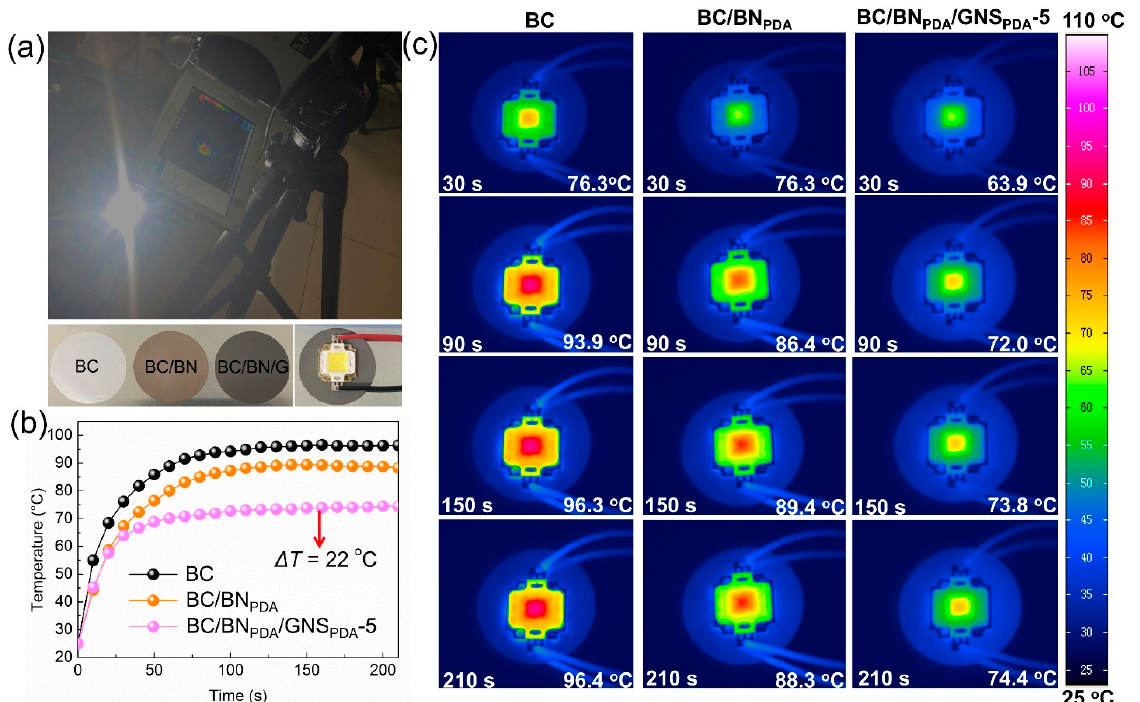
Figure 5. ( a ) Experimental con fi guration for testing the heat transfer performance of BC, BC/BN PDA , and BC/BN PDA /GNS PDA -5 fi lms applied to LED chip heat dissipation. ( b ) Temperature evolution of LED chip as a function of running time and ( c ) the corresponding IR images of temperature distri- butions of BC, BC/BN PDA , and BC/BN PDA /GNS PDA -5 fi lms. The reduction of electron delocalization arising from the ionic characteristic of the B − N bond generally brings about large band gap of the BN fi ller, which provides the ex- cellent electrical insulating features of composites [41]. Conversely, the conjugated struc- tures of GNS has high electron mobility (2 × 10 5 cm 2 ·V − 1 ·s − 1 ) [24], which leads to poor elec- trical insulation properties. It was found, surprisingly, that the electrical insulation prop- erties can be regulated by controlling the mass ratio of GNS PDA . Figure 4d,e depicts the dielectric constant ( ε ) and dielectric loss (tan δ ) of composite fi lms at varied fi ller content. It can be seen that the ε and tan δ values of BC/BN PDA /GNS PDA -5 fi lms are clearly reduced with the increase in hybrid fi llers contents, which has a similar trend seen in the literature [5,37]. For example, the ε and tan δ values of the BC/BN PDA /GNS PDA -5 composite fi lm with 70 wt% hybrid fi llers contents separately reach the extremely low values of 6.3 and 0.03 at the frequency of 1000 Hz, which are lower than that of the fi lm with 10 wt% hybrid fi llers (8.1 and 0.05). This is because the BN is the main fi ller, which exhibits an extremely low values of ε and tan δ (~ 4, ~5 × 10 − 4 ) [42]; that being said, some studies have reported that the addition of GNS causes the enhancement of ε due to the interfacial polarization e ff ect and the formation of the micro-capacitance [43]. However, for the hybrid fi ller of the pre- pared BC/BN PDA /GNS PDA -5 fi lm, the content of GNS fi ller (5 wt%) is much lower than that of the BN fi ller (95 wt%), and the small amount of GNS is isolated by numerous BN fi llers, so the GNS fi ller fails to form micro-capacitances inner composites. However, when the mass ratio of GNS PDA increases to 10 wt%, the ε and tan δ values for the BC/BN PDA /GNS PDA - 10 fi lm increase to 7.8 and 0.05, which are apparently increased relative to the BC/BN PDA /GNS PDA -5 fi lm. This result shows that when the amount of GNS fi llers exceeds the critical value, GNS fi llers might connect to each other, resulting in the interfacial po- larization e ff ect [44]. Therefore, when the content of GNP is about 5 wt%, it is bene fi cial to ensure that the composite fi lm exhibits excellent dielectric properties. Moreover, as pre- sented in Figure 4f, at the fi xed GNS PDA of 5 wt%, the AC conductivity of